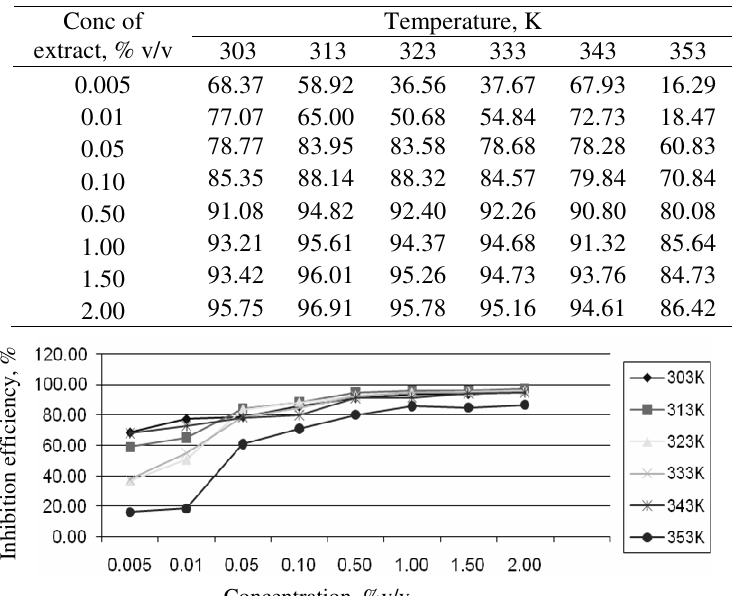
Figure 2. Influence of immersion time on inhibition efficiency of mild steel in various concentrations of MNP extract in 1 N HCl Table 2. Effect of temperature on mild steel corrosion in 1 N HCl in absence and presence of MNP extract